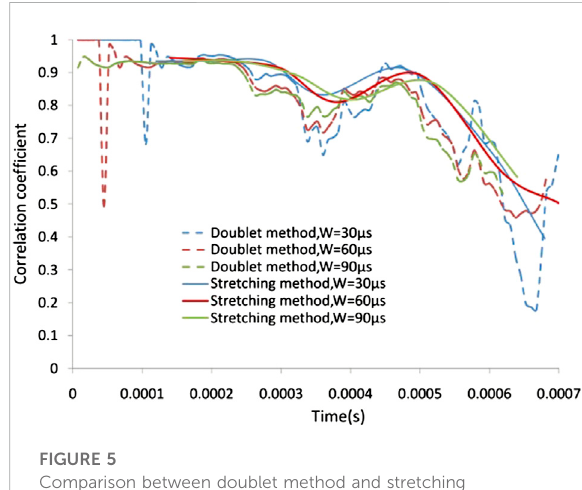
FIGURE 5 Comparison between doublet method and stretching